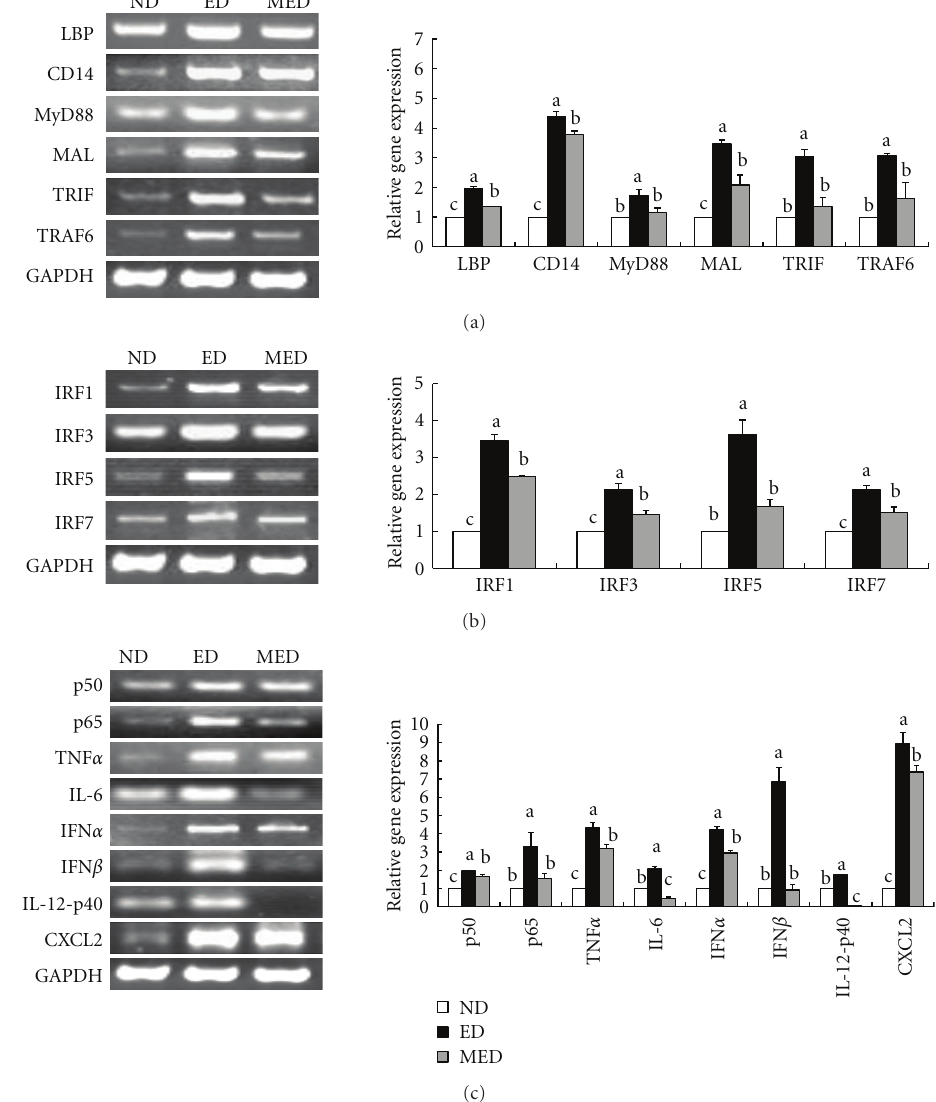
Figure 5: mRNA expressions of the hepatic genes that were involved in the inflammation. The left panel shows the results of the RT-PCR analysis of the (a) LBP, CD14, MyD88, MAL, TRIF, and TRAF6, (b) IRF1, IRF3, IRF5, and IRF7, and (c) p50, p65, TNF α , IL-6, IFN α , IFN β , IL-12-p40, and CXCL2 expressions. The images show the representative agarose gel electrophoresis of the PCR products. The right panel shows the relative expressions of the (a) LBP, CD14, MyD88, MAL, TRIF, and TRAF6, (b) IRF1, IRF3, IRF5, and IRF7, and (c) p50, p65, TNF α , IL-6, IFN α , IFN β , IL-12-p40, and CXCL2 levels. The data were normalized to the GAPDH levels, and all the expression levels that are shown are relative to the ND. The results that are shown represent the means ± SEM of the three independent experiments in which RNA samples from eight mice were used. a,b,c Means not sharing a common letter are significantly di ff erent ( P < 0 .